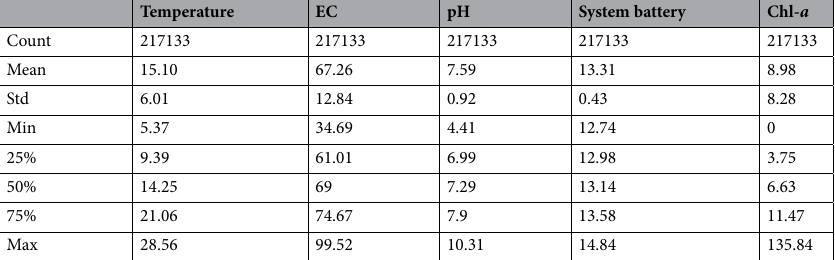
Table 1. Statistical description of the collected data: number of collected data points (count), mean value, standard deviation value (std), minimum value (min), 25%, 50% and 75% percentile values, and maximum value (max). Variables (columns): temperature (